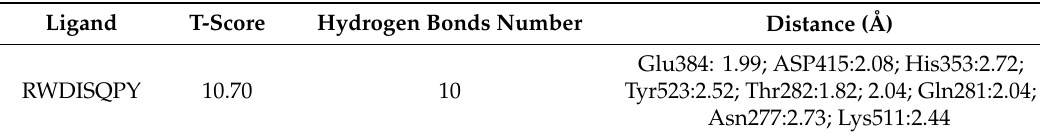
Table 3. Docking scores and hydrogen bonds observed between the peptide RWDISQPY and ACE from the molecular docking